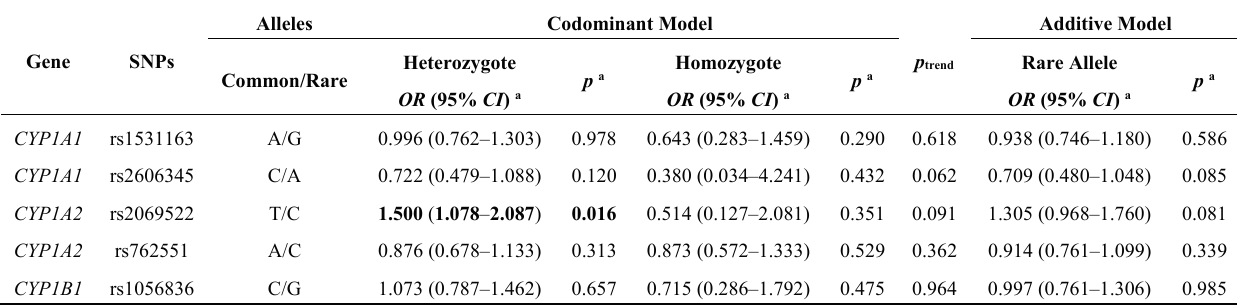
Table 3. Single SNPs in estrogen metabolism genes and association with breast